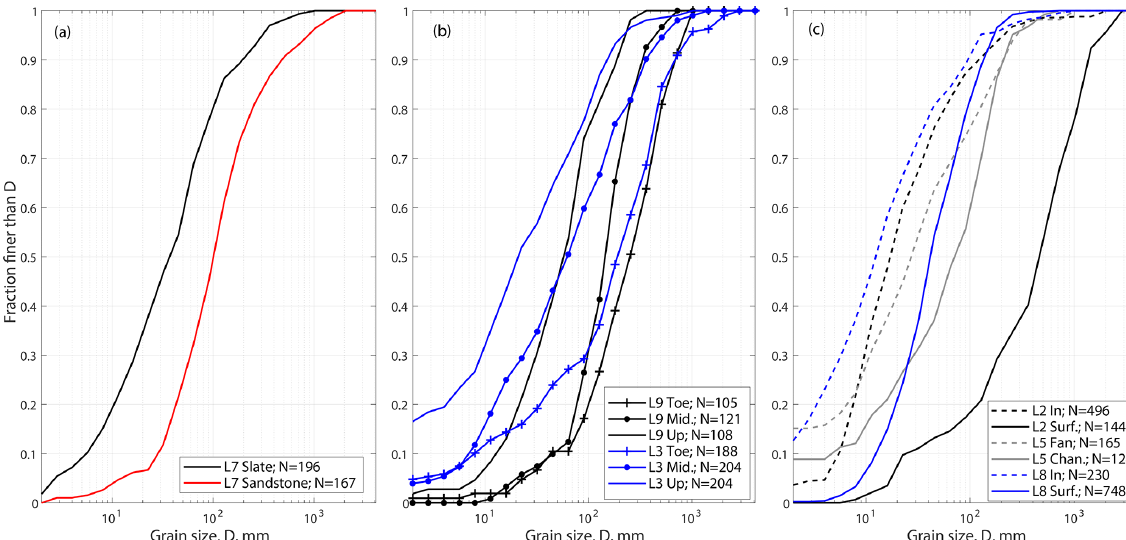
Figure 3. Examples of three types of heterogeneity in grain size distributions within the same landslide deposit: (a) lithological difference within the deposit of LS-7 with sandstone grains coarser than slate grains; (b) downslope differences between the upper, middle and lower part of the deposits of LS-3 and LS-9; (c) difference between the surface and inner part of the deposits of LS-2, LS-5 and